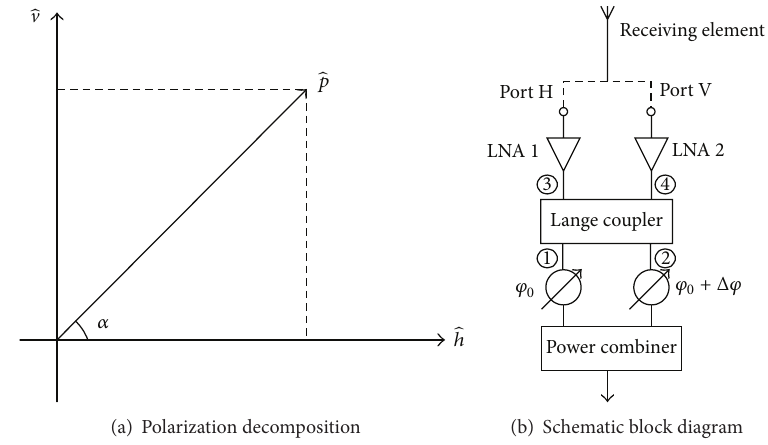
Figure 10: The polarization tracking module for receiving application.